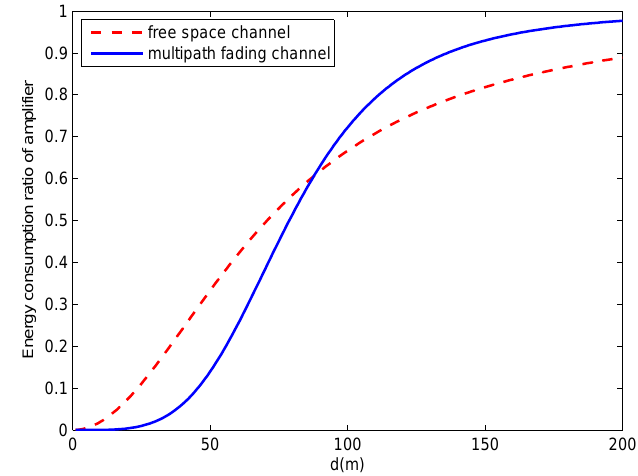
Figure 3. The power amplifier energy consumption to total energy consumption